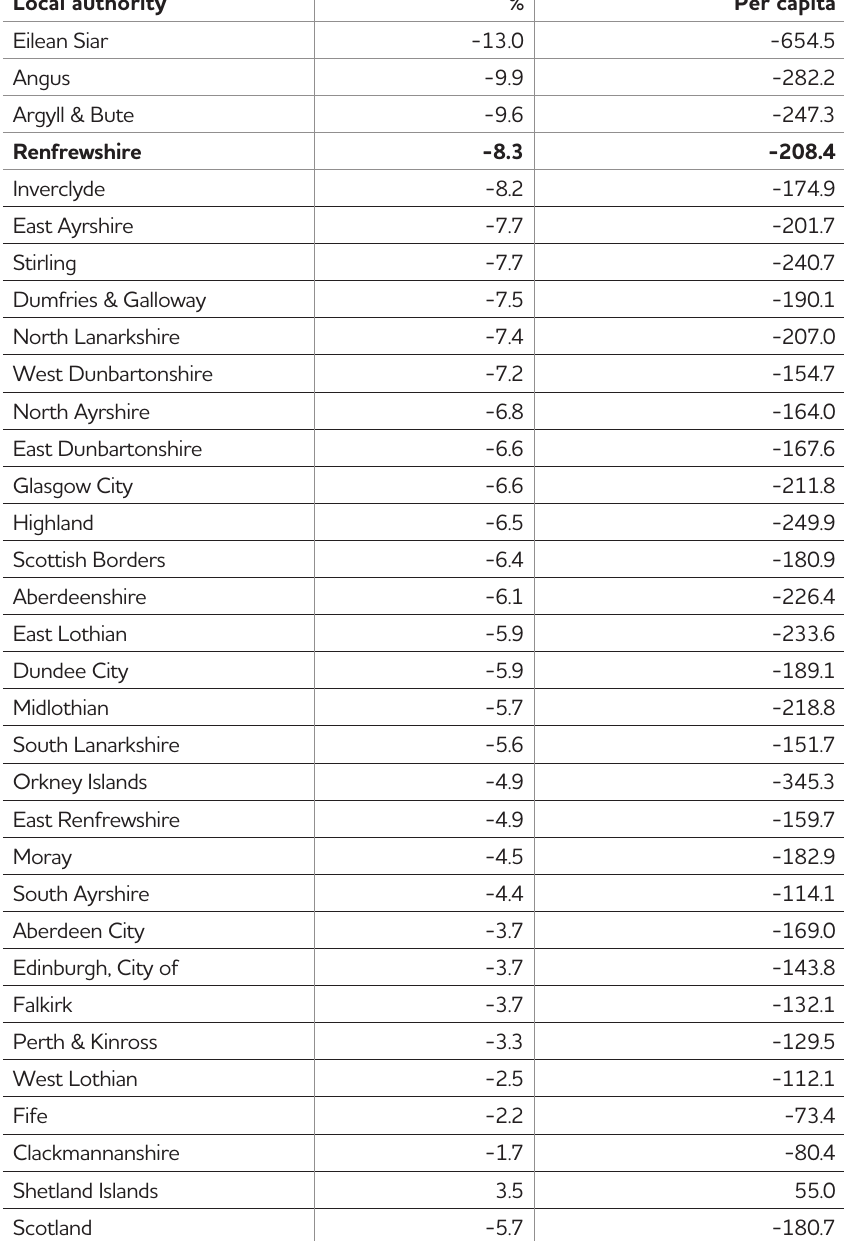
Table 1: Real expenditure change by Scottish local authorities, in percentage and per capita terms,